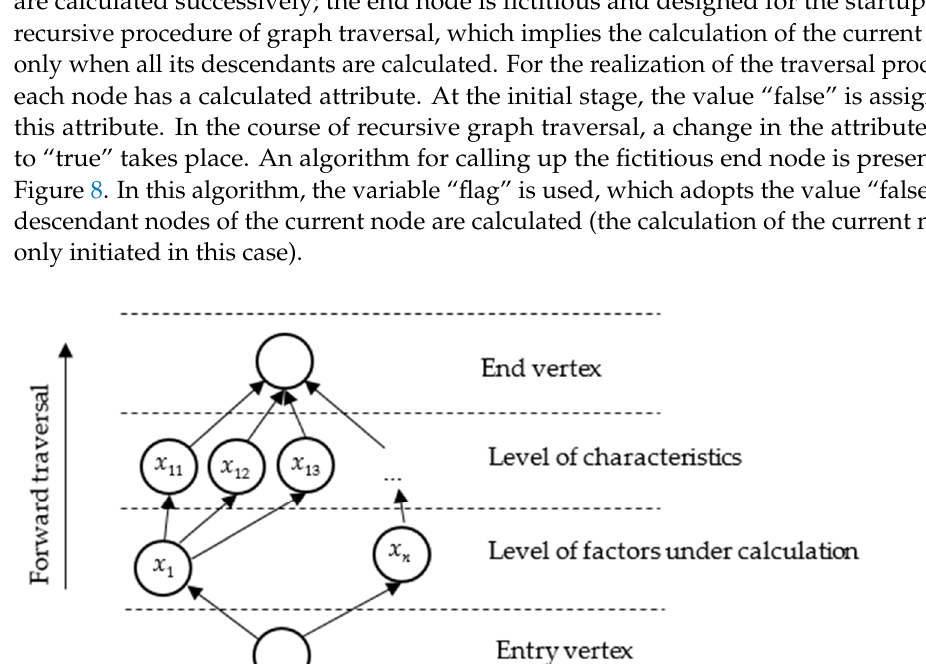
Figure 7. Graph of results processing. Forward traversal can also be used for the traversal of the factor tree when, for example, the solution of an inverse problem is determined on the basis of a direct problem solution. Thus, the solution to the inverse problem includes the traversal of three layers, for which a tree/graph is formed in each case (Figure